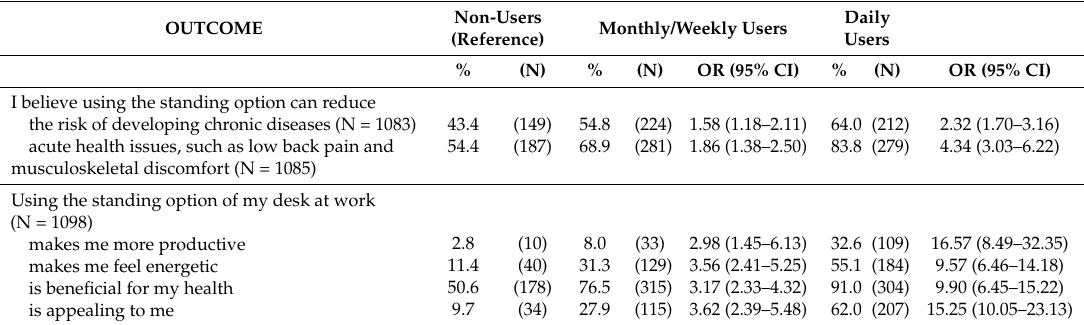
Table 4. Agreement with perceived positive perceptions of the use of the sit-stand workstation and Odds ratios (95% CI) for three user groups, with non-users as reference category.